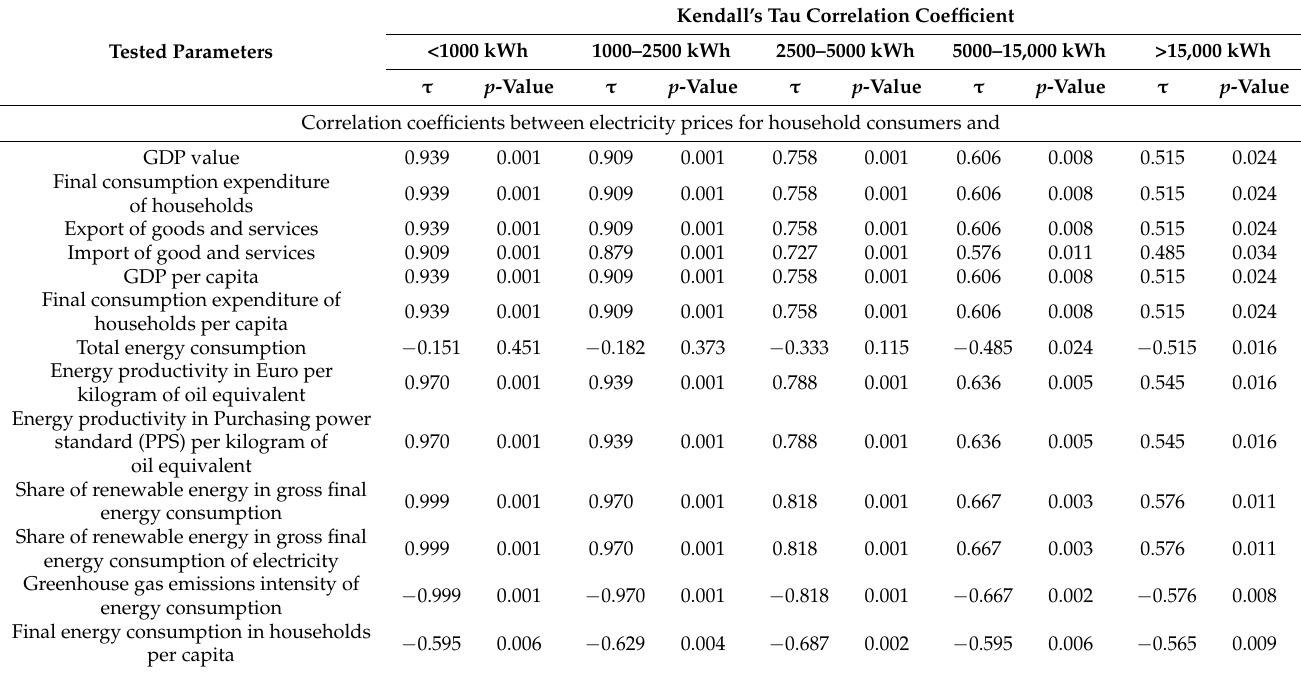
Table 3. Kendall’s tau correlation coefficients between energy economy parameters and the electricity prices for private customers in the